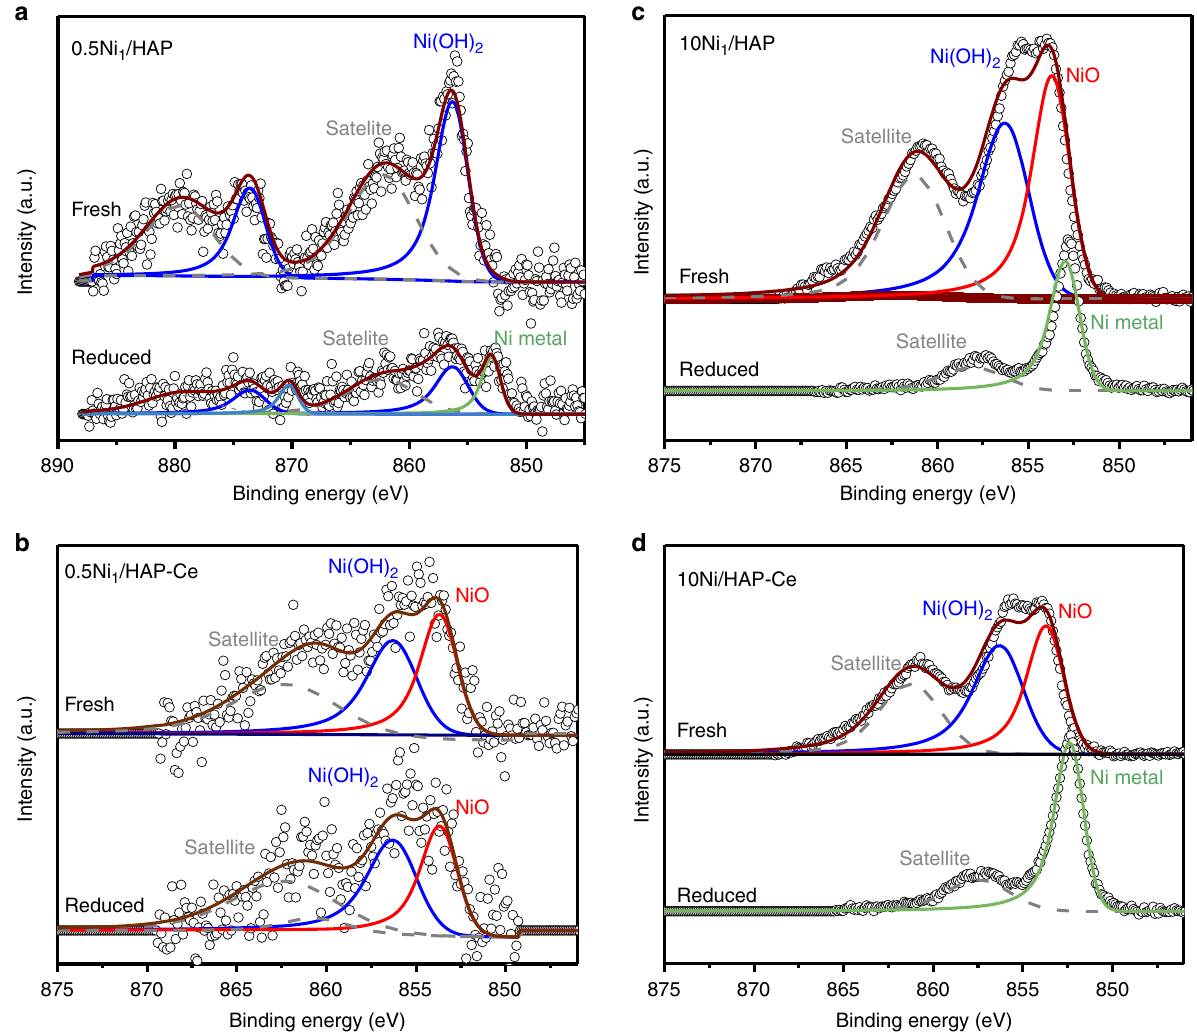
Fig. 3 In-Situ XPS analysis of Ni/HAP and Ni/HAP-Ce samples. a High resolution Ni 2p XP spectra of as-prepared and in situ reduced: 0.5Ni 1 /HAP, b 0.5Ni 1 /HAP-Ce, c 10Ni/HAP, and d